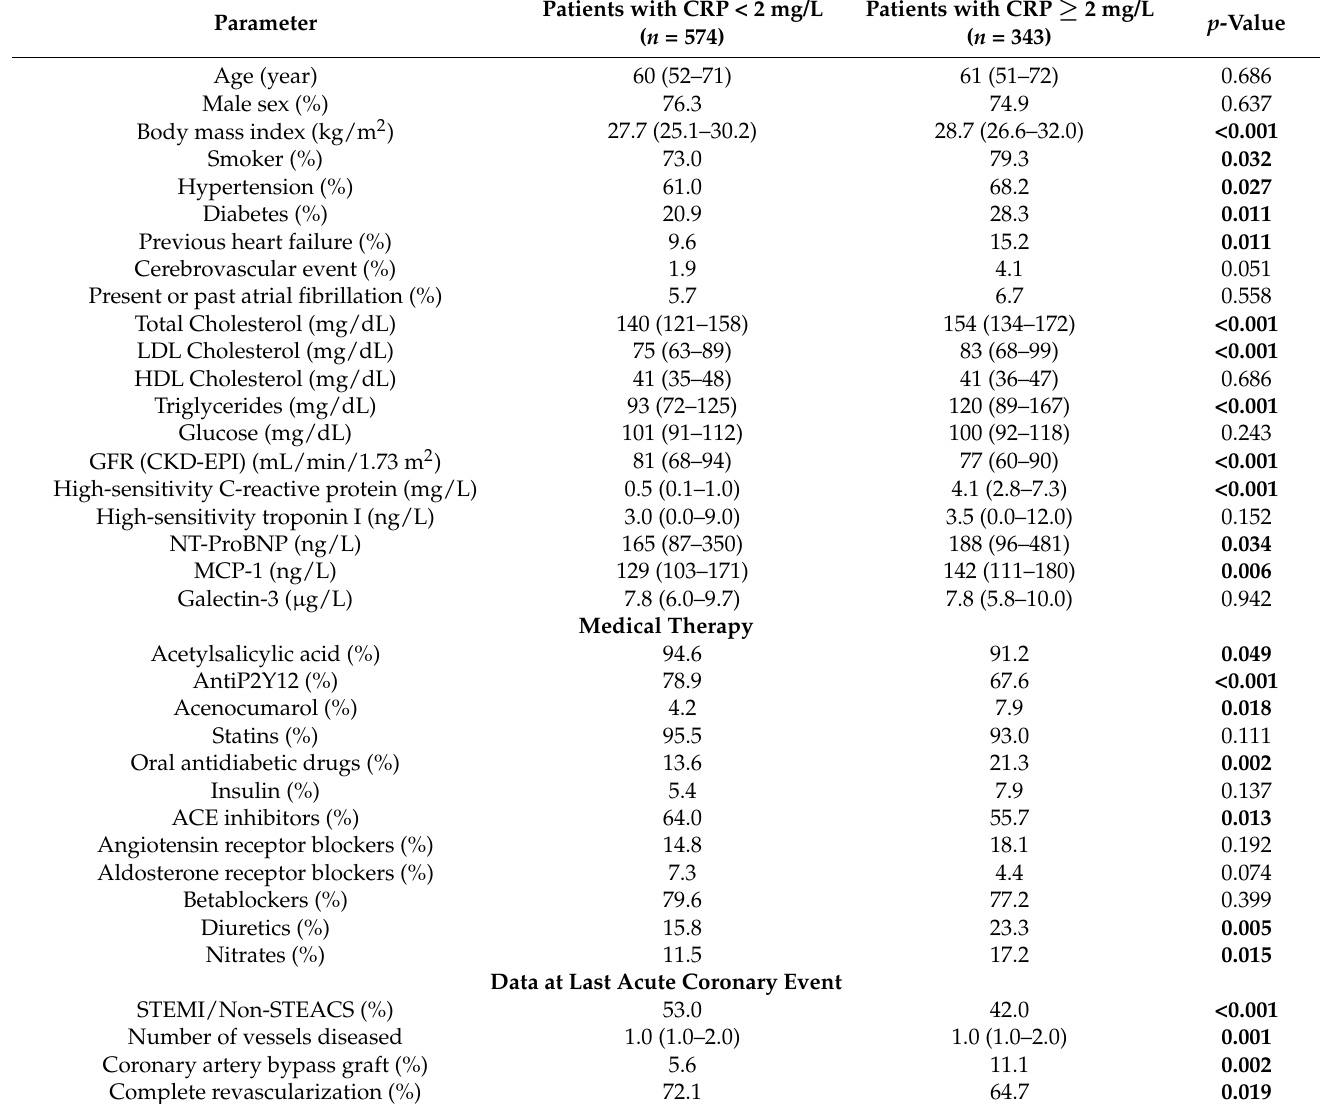
Table 1. Characteristics of the studied population according to C-reactive protein (CRP)